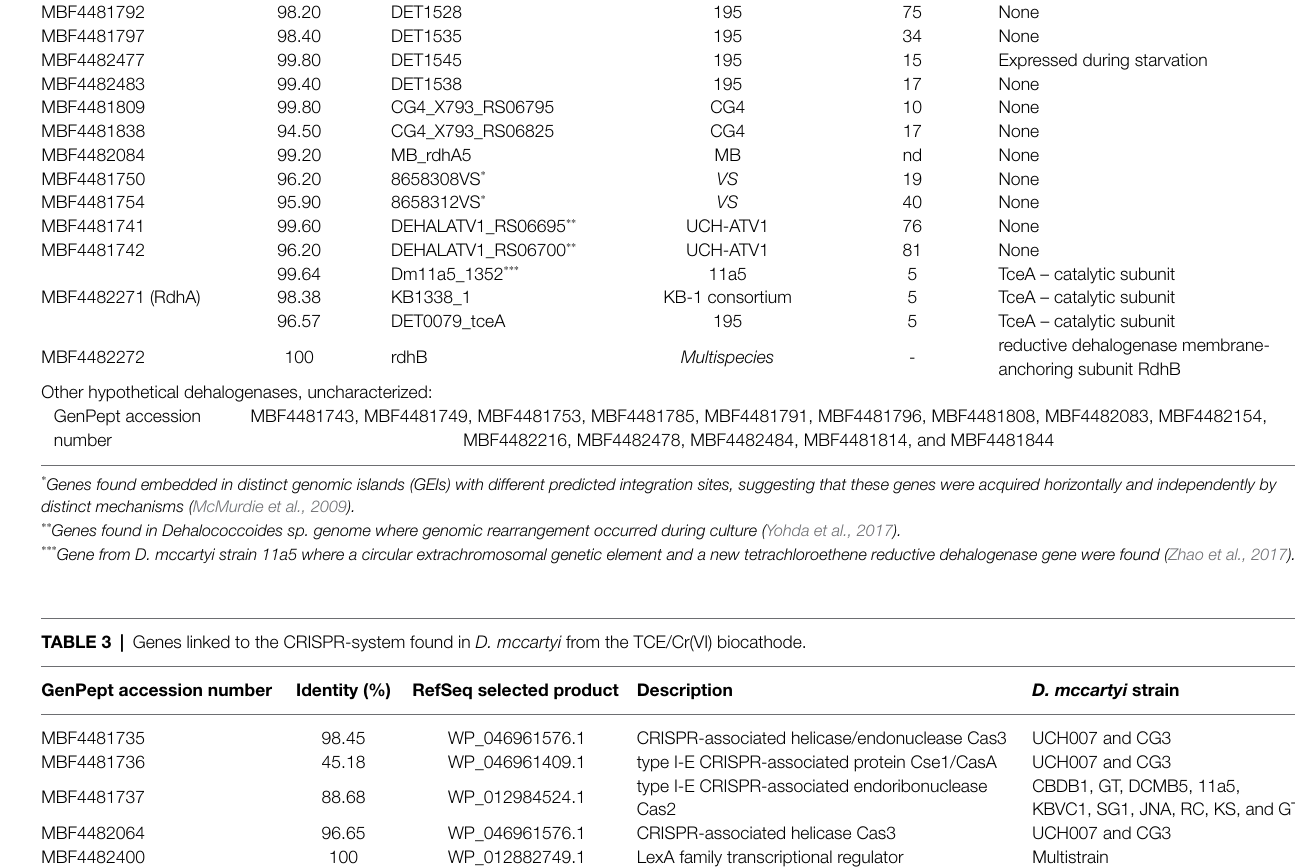
TABLE 2 | Reductive dehalogenase genes annotated in the genome of D. mccartyi extracted from the TCE/Cr(VI) biocathode. GenPept accession Identity (%) number